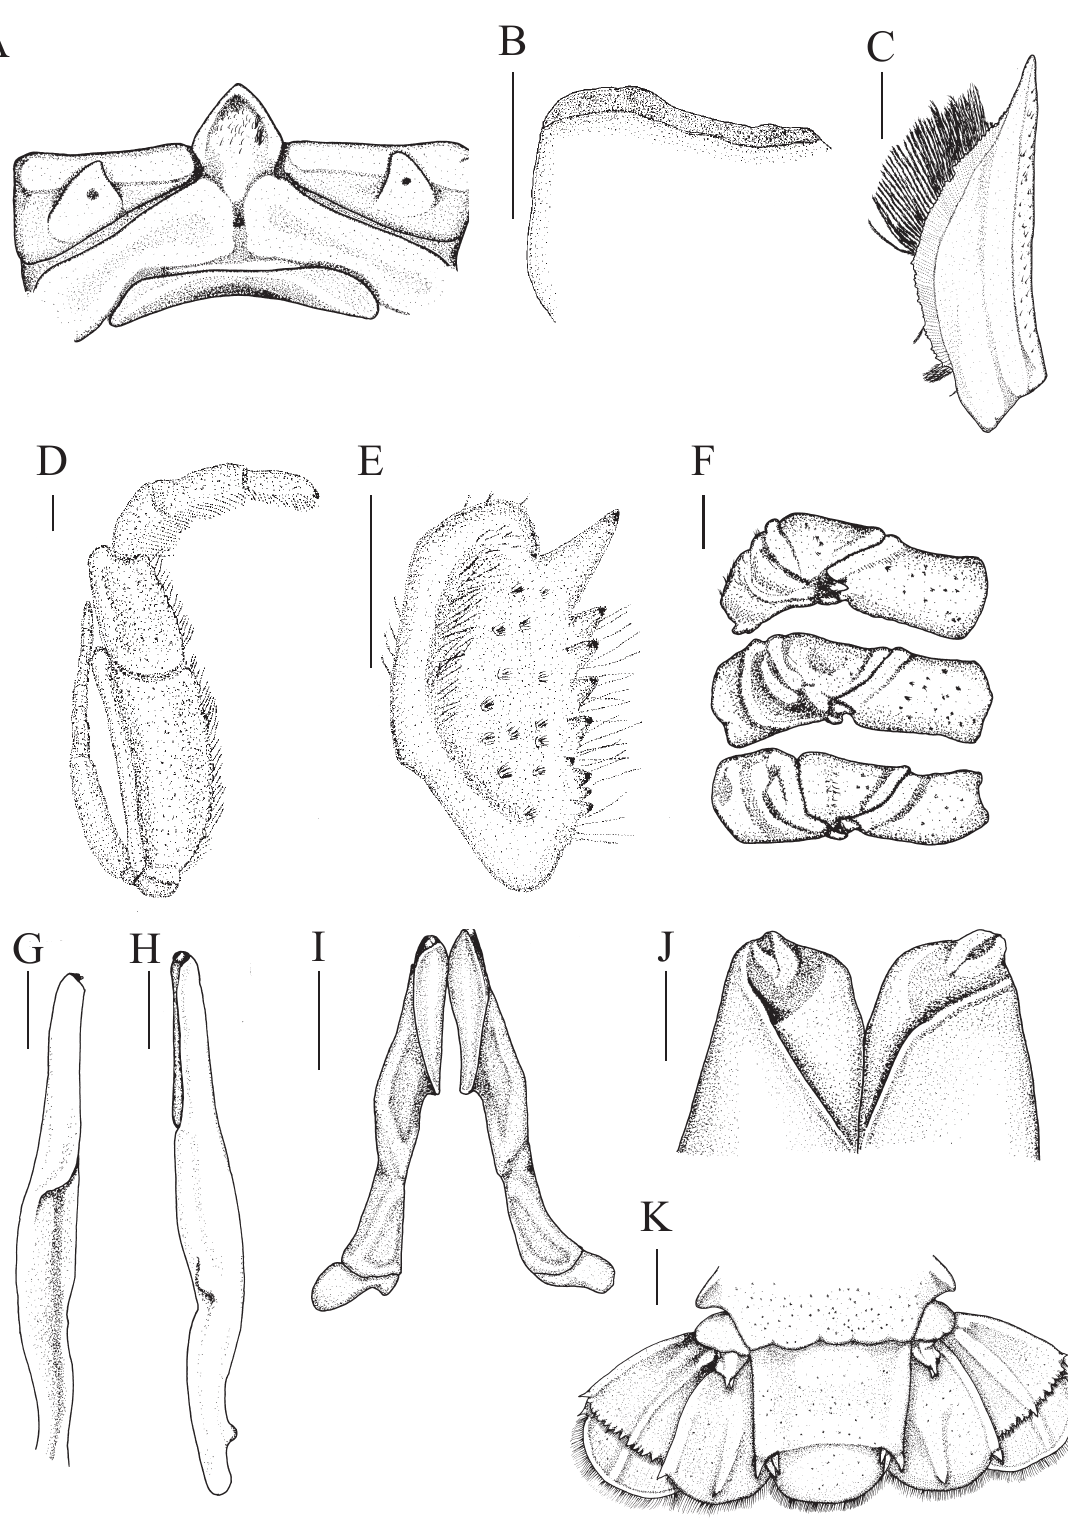
Figure 2. Pacifastacus leniusculus leniusculus (Dana, 1852): all figures from syntypic male (USNM 44408). A, Epistome and base of antennae; B, distocaudal view of denticle of mandible; C, dorsal view of antennal scale; D, ventral view of third maxilliped; E, dorsal view of merus of third maxilliped; F, proximal podomeres of pereiopods; G, mesial view of first pleopod; H, lateral view of first pleopod (gonopod); I, ventral view of first pleopod; J, ventral view of distal portion of first pleopod; K, dorsal view of telson and uropods. Scale bars = 2 mm, except B = 0.5